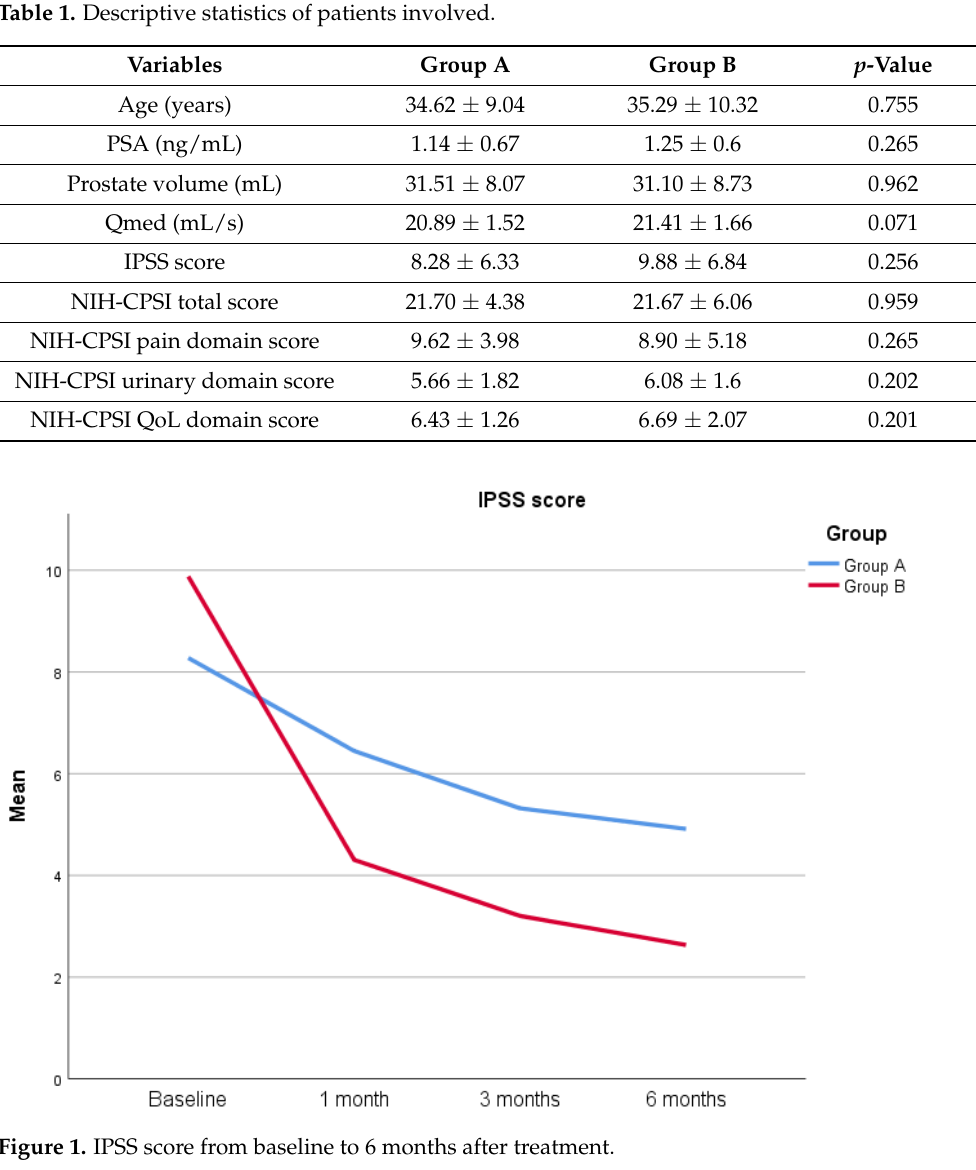
Figure 2. NIH-CPSI total score from baseline to 6 months after treatment. 4. Discussion Patients with chronic prostatitis represent a common and wide challenge in urologi- cal practice [23 – 25]. Although conventional therapies and antibiotic therapy are the main- stays of treating this condition, a proportion of patients do not respond to treatment de- spite reporting negative prostatic fluid cultures [26]. It has been proposed that chronic prostatitis may represent an inflammatory dysregulation in response to persistent chem- okine upregulation, oxidant stress and cellular injury [27,28]. As long as an initial diagno- sis of chronic prostatitis is established, it is evident that the condition is not a single disease entity, as different factors may be involved even in a single patient [29,30]. The use of antibacterial agents may not achieve the complete eradication of the infection due to mul- tifactorial reasons, such as the poor distribution of drugs to the prostatic tissue, inadequate duration of antibiotic therapy or chemical modification in situ, which could impair the